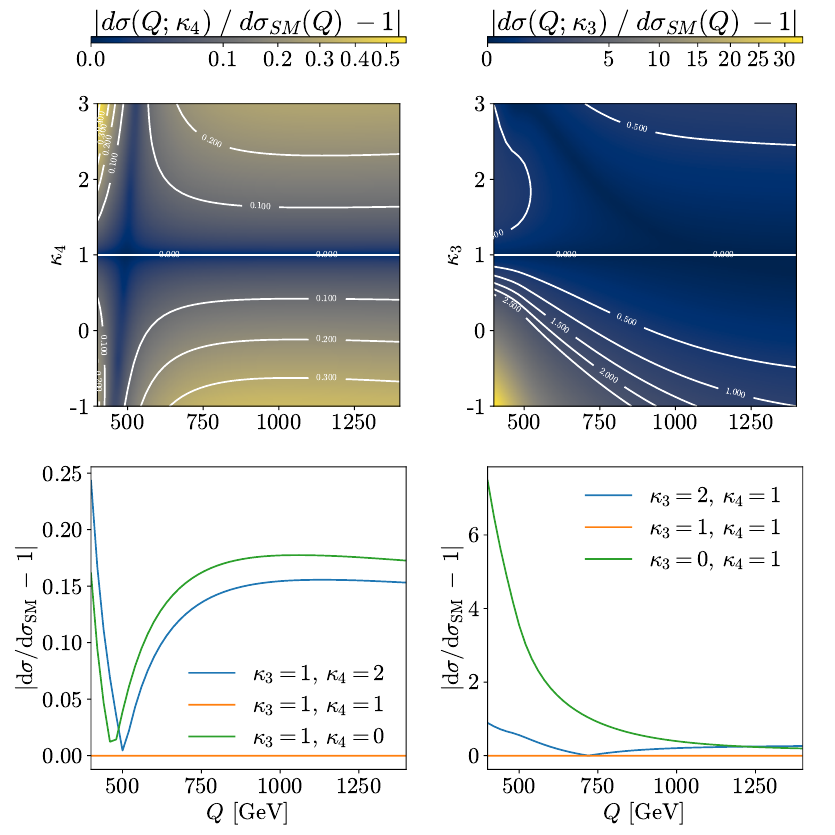
Figure 4 . Departure from the SM of the triple Higgs boson invariant mass distribution for contin- uum (top) or discrete (bottom) values of (cid:20) 4 (left) and (cid:20) 3 (right). Due to the quadratic dependence of (cid:27) on the couplings, a nonlinear colormap is used for better visualisation. of the form factors in eq. (2.2), making the (cid:20) (cid:20) -independent 4